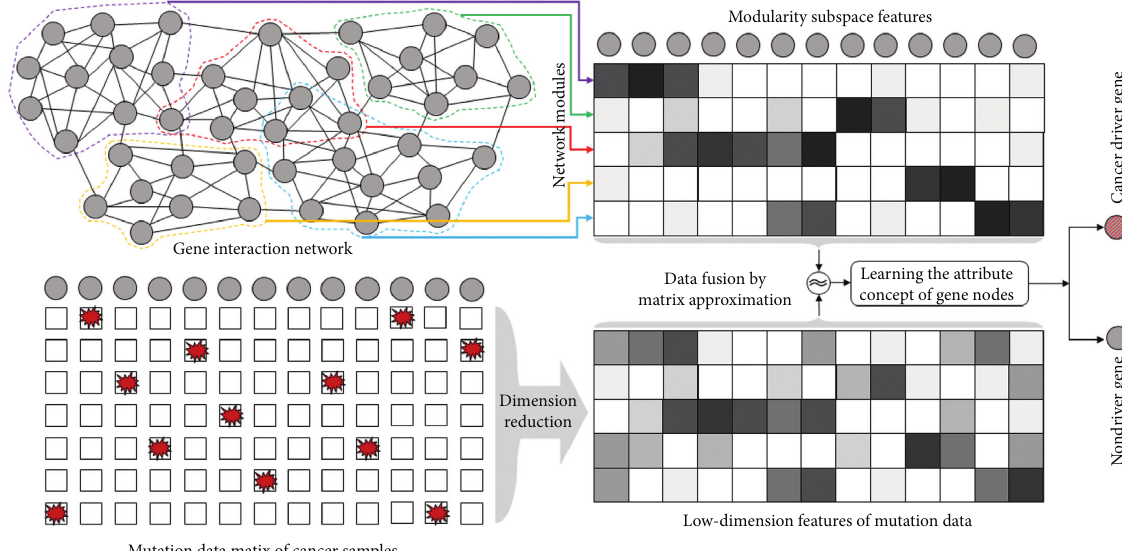
Figure 1: Schematic plot of pipeline of the proposed modularity subspace based concept learning model. The network modules and reduced dimensions are fused as the gene features in driver attribute concept